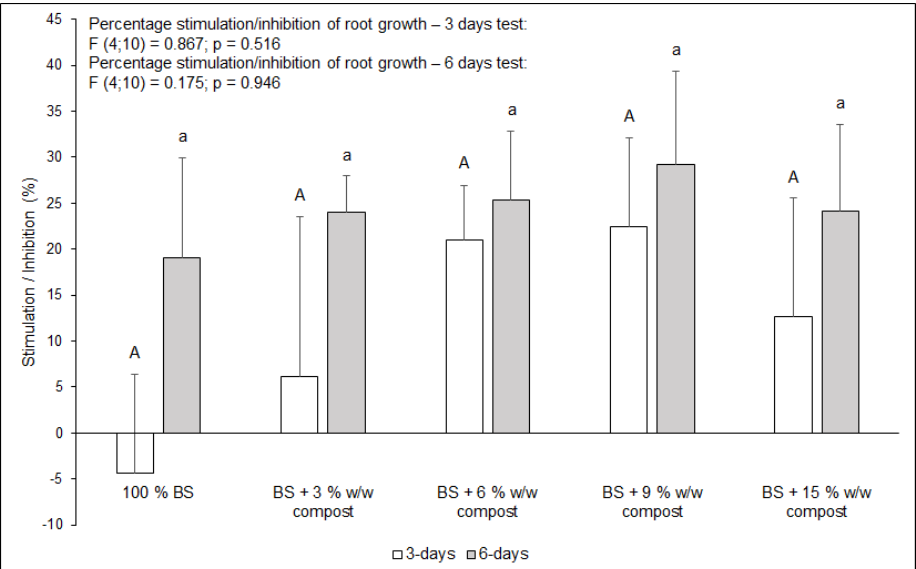
Comment: Different letters indicate significant differences between individual variants within 3 or 6 days of testing. Sym ‐ bol * represents significant differences between 3 and 6 days of testing within one variant. Figure 7. Comparison of inhibition/stimulation of root growth of Lepidium Sativum L. after 3 and 6 days of exposure to burnt soil supplemented with compost in increasing proportions (compared to OECD soil). Average values (n = 3) + SE are presented, different uppercase letters indicate significant differences between individual variants after 3 days of testing and small letters after 6 days (one-way ANOVA with post hoc Tukey’s HSD test). The results of the F test are shown at the top of the graph.